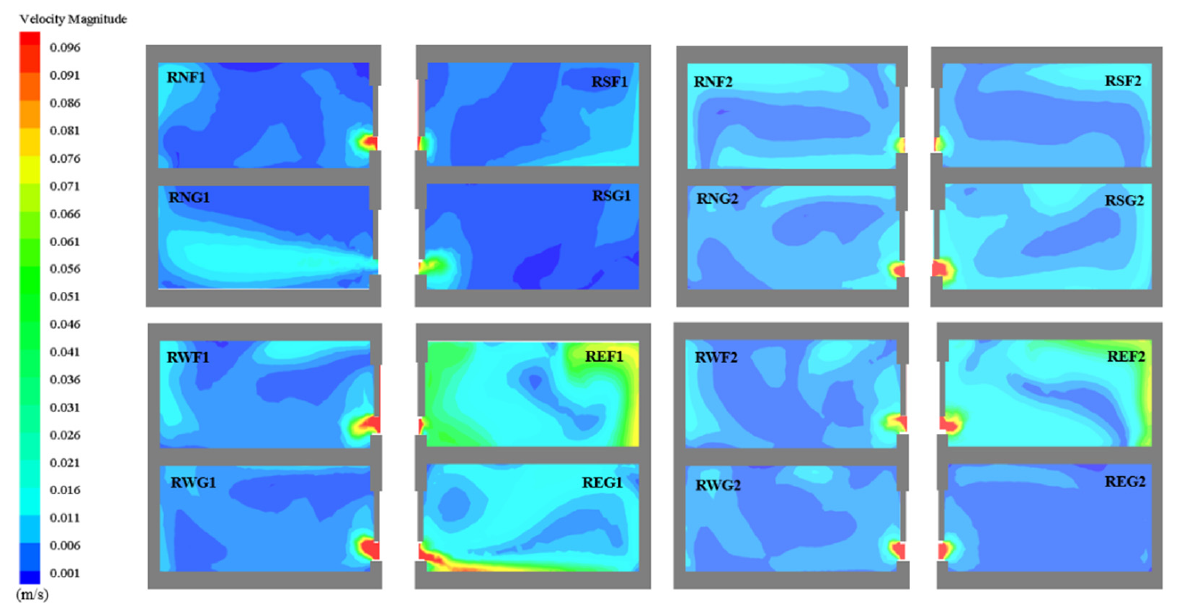
Figure 21. Contours of the wind speed in each room for the baseline courtyard model with four small trees.